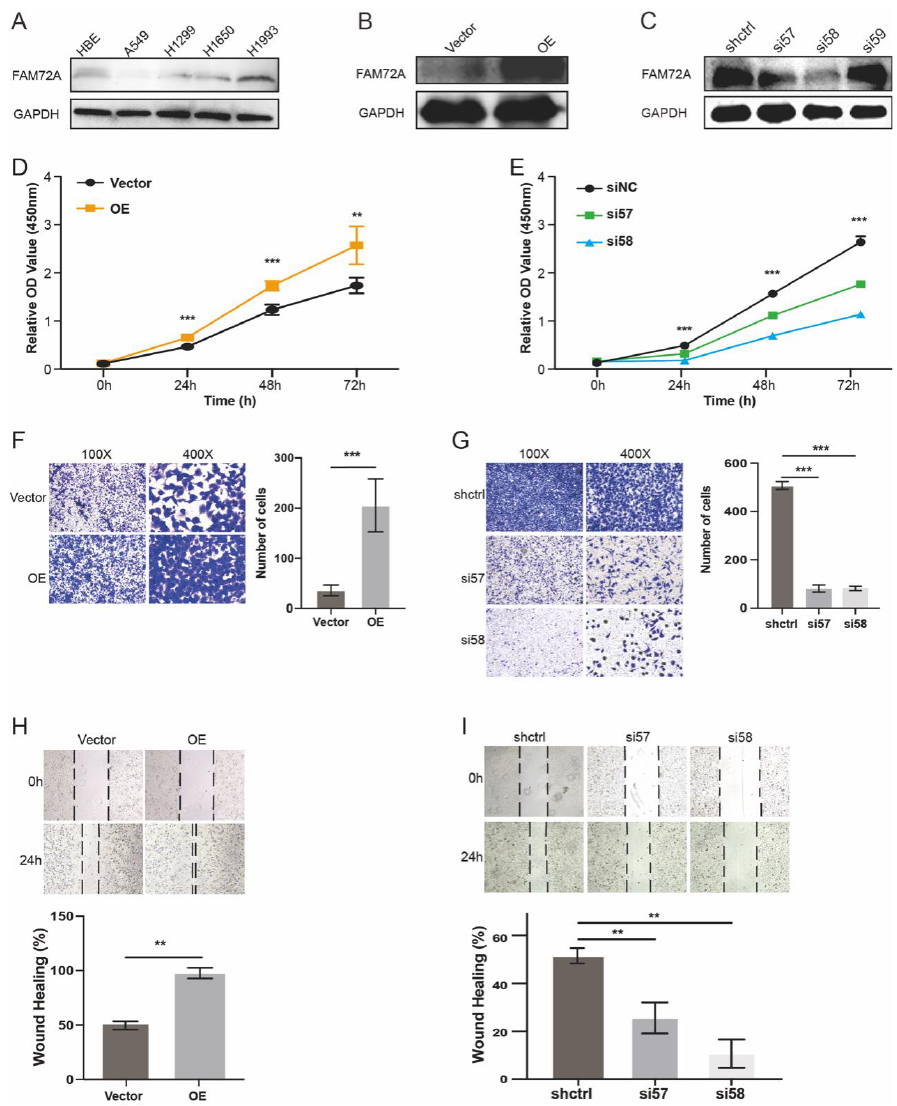
Figure 8. Validation of the potential function of FAM72A in tumors by in vitro assays. ( A ). Differential expression of FAM72A in normal lung bronchial epithelial cells and lung cancer cells by Western blot analysis. ( B , C ). Examination of FAM72A expression in A549 ( B ) and H1993 cells ( C ) stably infected lentiviral vectors overexpressing FAM72A and lentiviral vectors carrying shFAM72A, respectively. The overexpression of FAM72A promotes the proliferation of A549 cells by CCK-8 assay ( D ), Transwell assay ( F ), and wound healing test ( H ). Knockdown of FAM72A inhibits the proliferation of H1993 cells by CCK-8 assay ( E ), Transwell assay ( G ), and wound healing test ( I ). * p < 0.05, ** p < 0.01, and *** p < 0.001.